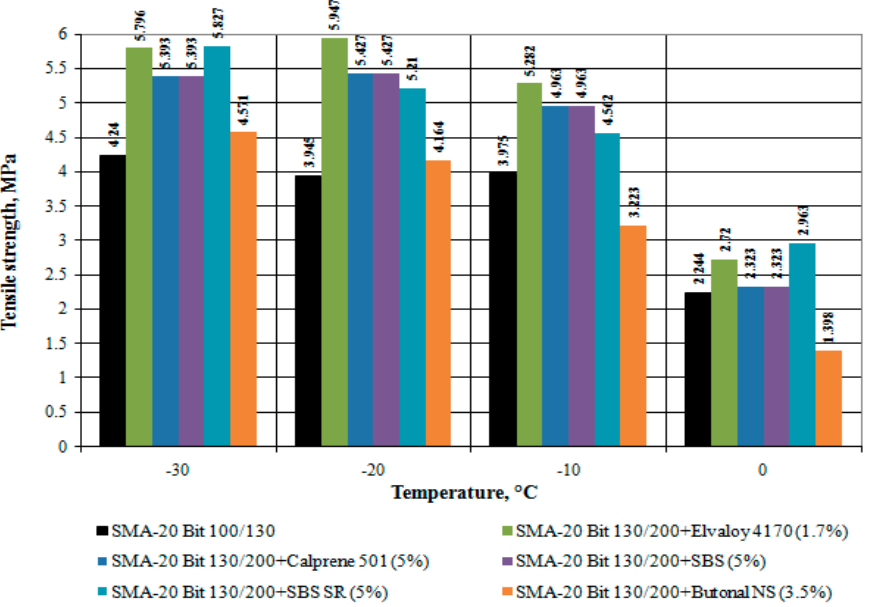
Figure 19. Strength of the stone mastic asphalt concretes in initial condition at low temperatures.